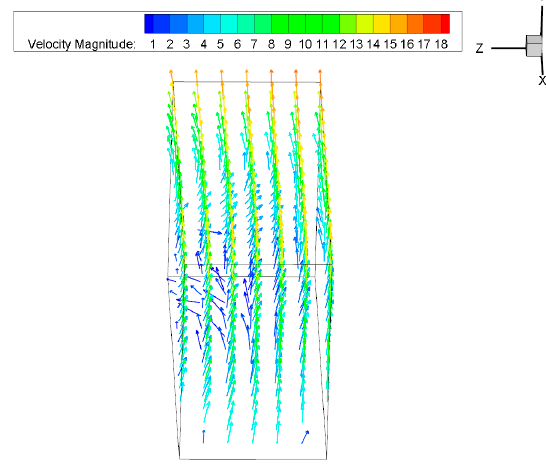
Figure 14. Average velocity field view of the leading edge (LE) dimpled airfoil at the 15-degree AoA.